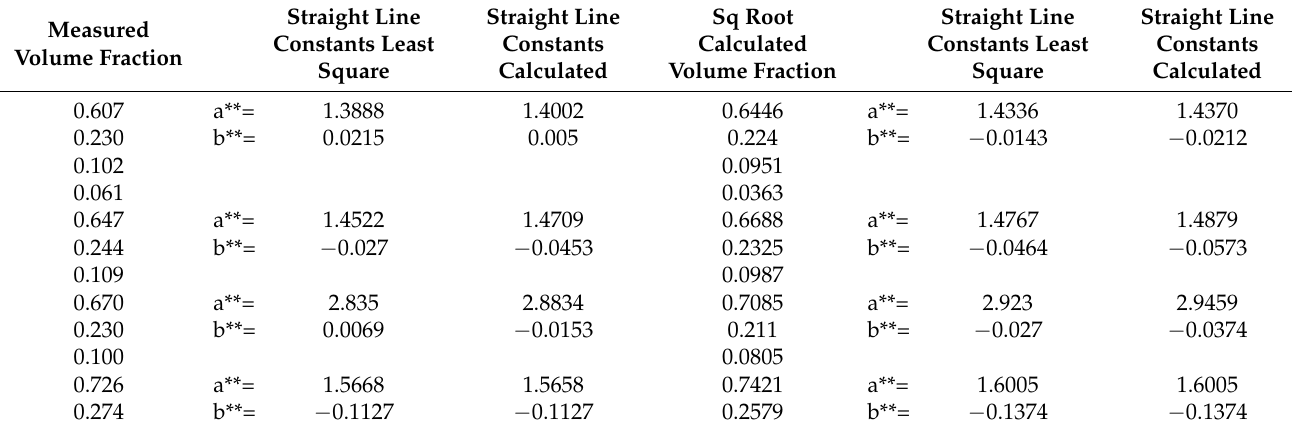
Table 3. Slope and intercept values for McGeary’s straight line plots compared with the calculated straight line plots.